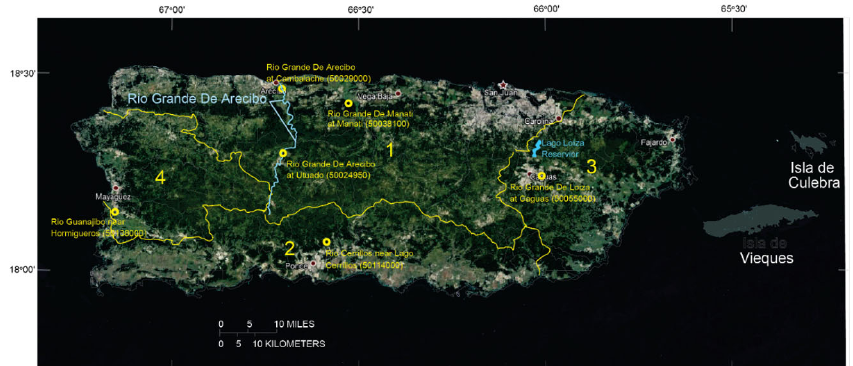
Figure 2. Four hydrogeographic regions in Puerto Rico [7] and location of streamgaging sites. These four regions are (1) a moderate rainfall region north of the Cordillera Central (Figure 1), (2) a dry region south of the Cordillera Central, (3) a wet region east of the Cordillera Central surrounding Sierra de Luquillo (Figure 1), and (4) a moderate rainfall region west of the Cordillera Central.